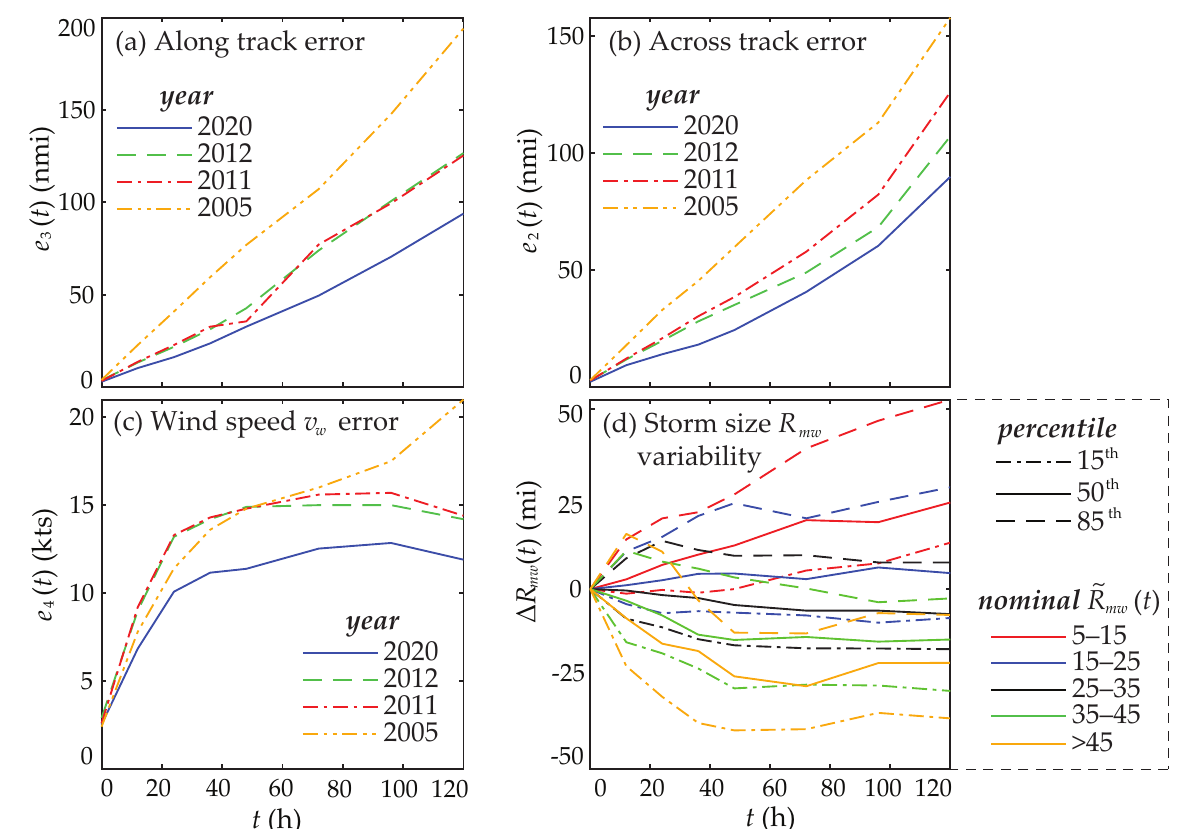
Figure 2. Uncertainty description as a function of time for the storm characteristics: ( a – c ) 5-year mean absolute error for the variation of the along-track, cross-track, and the wind speed, respectively, for four different error descriptions [2005, 2011, 2012, and 2020 updates of NHC forecast errors]; ( d ) the 15th, 50th, and 85th percentiles for the radius of maximum winds for different nominal radius